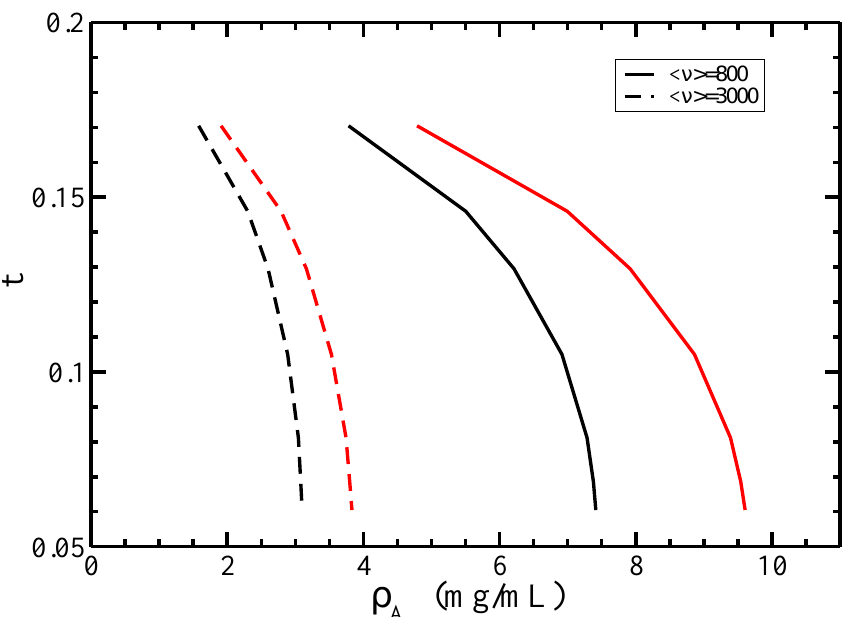
Figure 14. The isotropic–nematic phase diagram in terms of coexisting densities of actin ρ A for different values of the twisting parameter t . The average lengths of filaments are < ν > = 800 (solid lines) and 3000 (dashed lines); the persistence length P = 18 µ m, and the normalized standard deviation σ = 0.5. The coexisting isotropic and nematic densities are plotted in black and red colors,